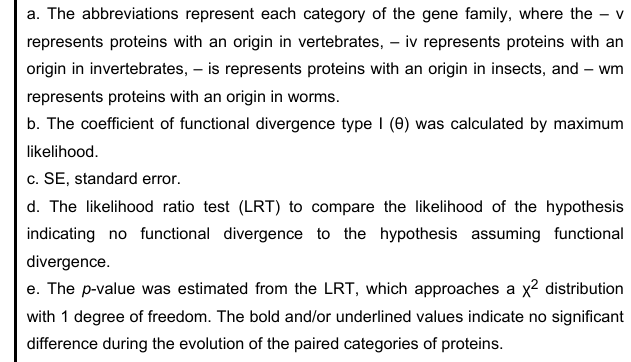
Table 1. Functional divergence analysis of complex members in